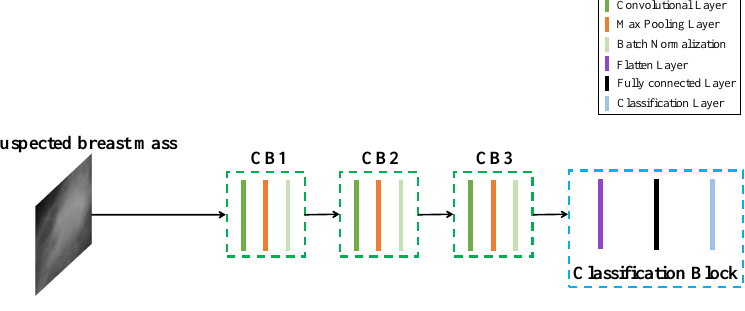
Figure 4. Architecture of